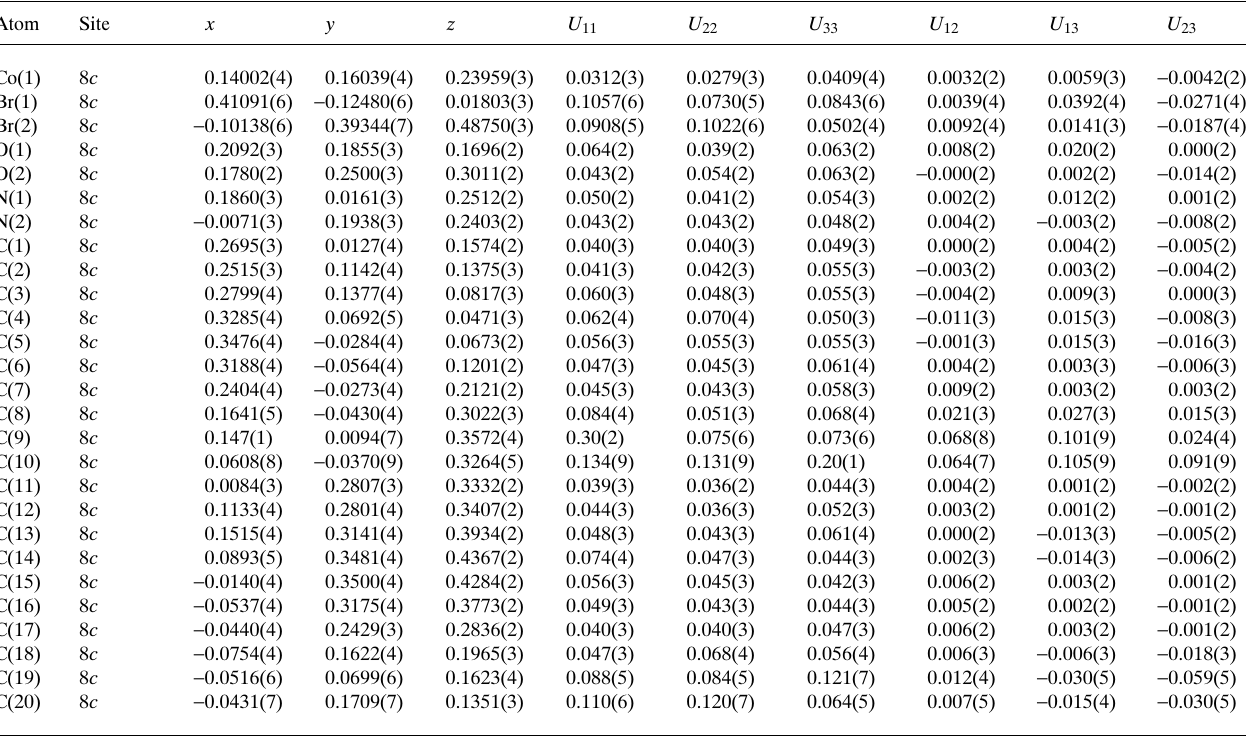
Table 3. Atomic coordinates and displacement parameters (in Å 2 )